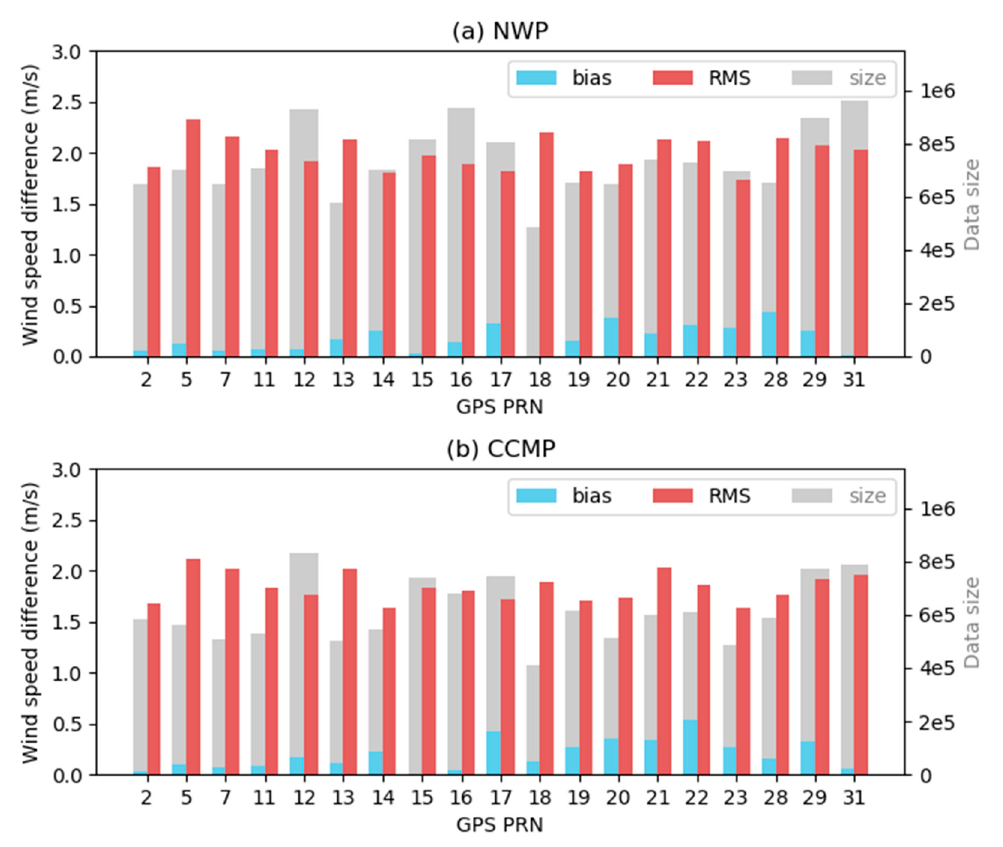
Figure 14. Wind speed inversion accuracy from the NWP-based reference wind ( a ) and CCMP-based reference wind ( b ) corresponding to different GPS PRN satellite types.